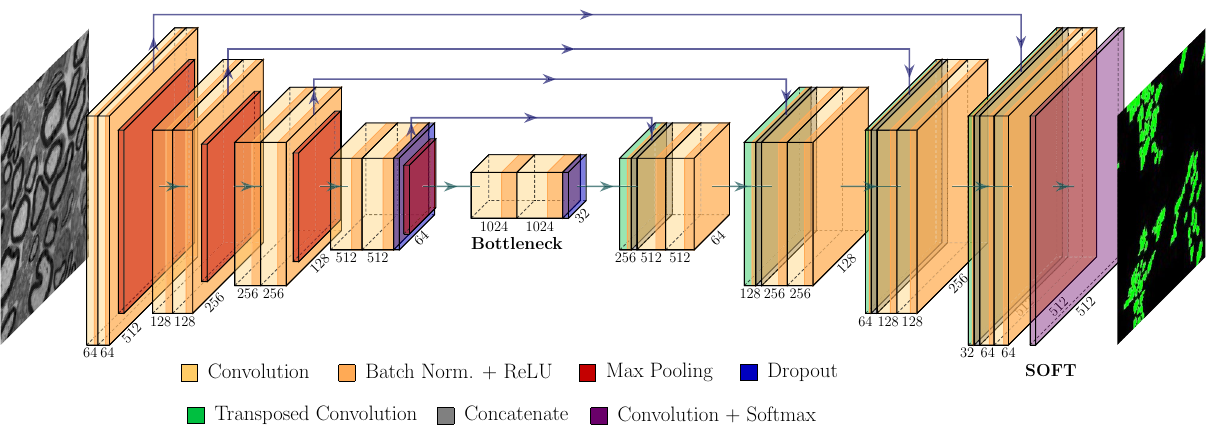
Figure 3. U-Net segmentation model on tiles of size 512 × 512 pixels, with 4 down-sampling (encoder) and up-sampling (decoder) blocks linked by skip connections. A batch normalization layer is inserted before the ReLU non-linearity in all the convolutional layers and dropout adds further regularization in the bottleneck. The image is drawn by PlotNeuralNet V1.0.0 27